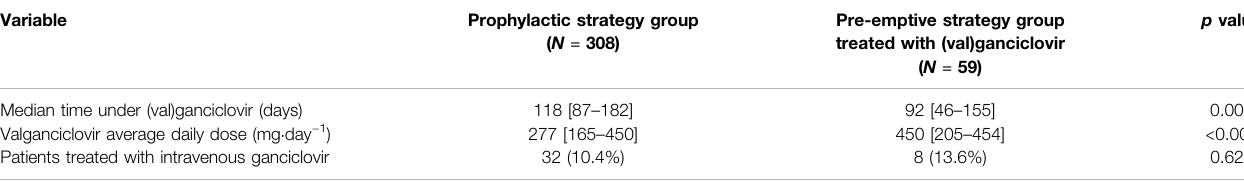
TABLE 2 | Antiviral treatment details for the two strategy groups. Variable